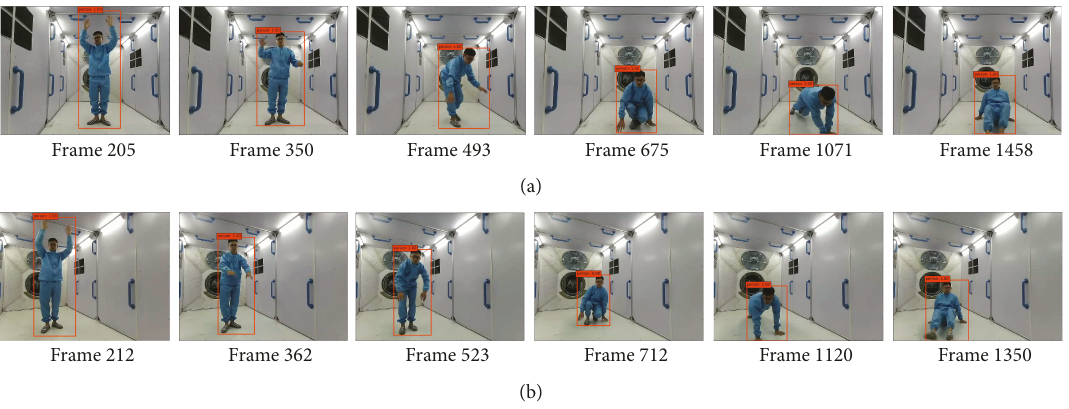
Figure 11: Detecting people of diverse postures from di ff erent views. Table 2: Result comparison of detecting people with diverse postures and